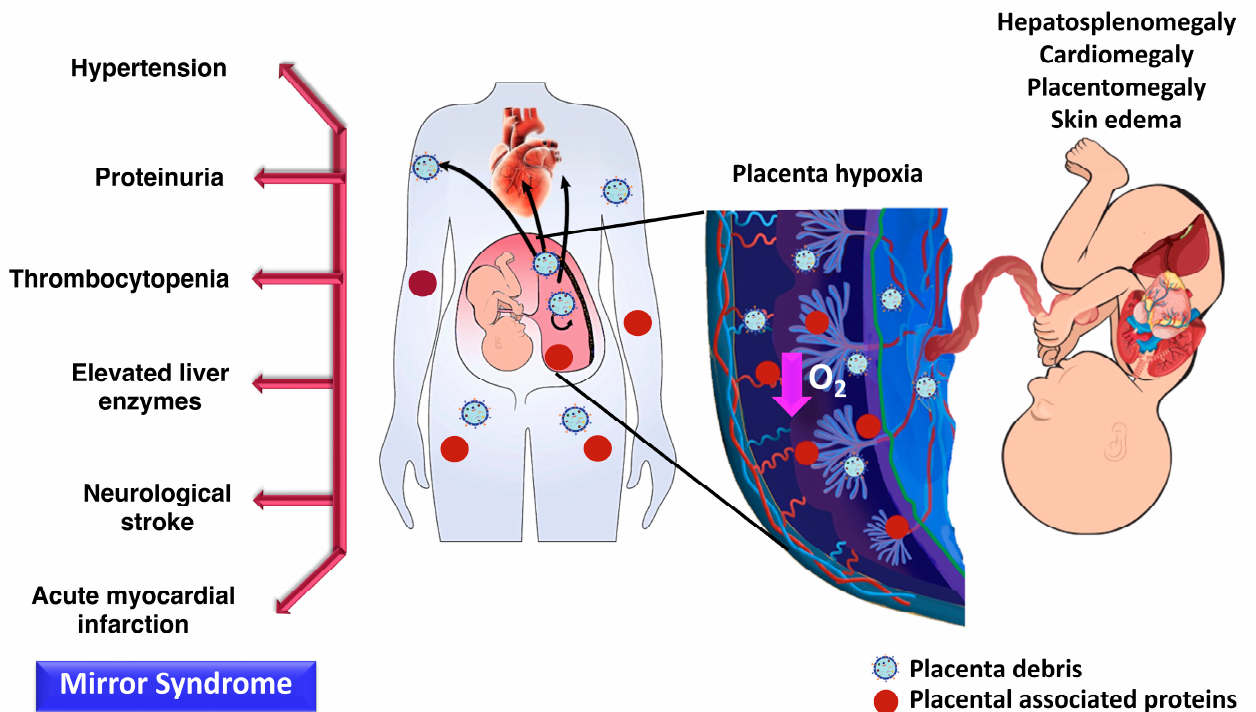
Figure 5. The possible roles of placenta-derived exosomes in the pathogenesis of Bart’s hydrops fetalis. Features of fetus with Bart’s hydrops are hepatosplenomegaly, cardiomegaly, ascites, pleural effusion, skin edema, and/or placentomegaly. Women with Bart’s hydropic fetuses can be presented with preeclampsia features called “mirror syndrome”. Placental hypoxia in Bart’s hydrops fetus is hypothesized to trigger the release of placental debris or placenta-derived exosomes which enter maternal circulation.